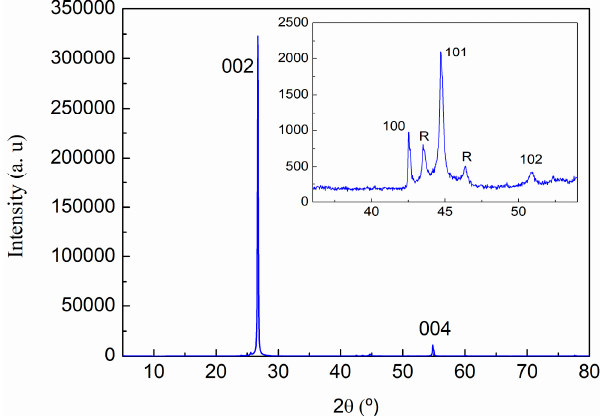
Figure 3. X-ray diffraction pattern of graphite with the assigned ( hkl ) Miller indices. Table 2. Measured interplanar spacings converted to lattice constants for graphite.